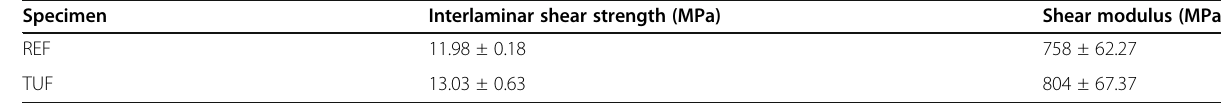
Table 1 Interlaminar shear strength and flexural modulus of REF and TUF biocomposite